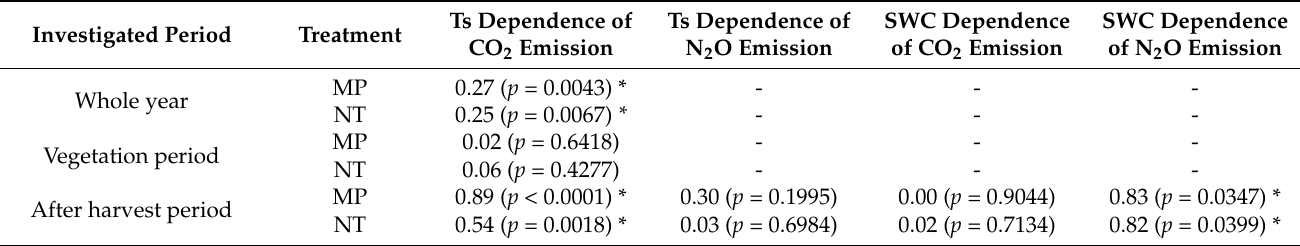
Table 12. Environmental drivers of GHG emission and its significance*. r 2 values are indicated. Tillage treatments: MP: mouldboard ploughing, NT: no-tillage. (Sample numbers are presented in Table 3). Investigated